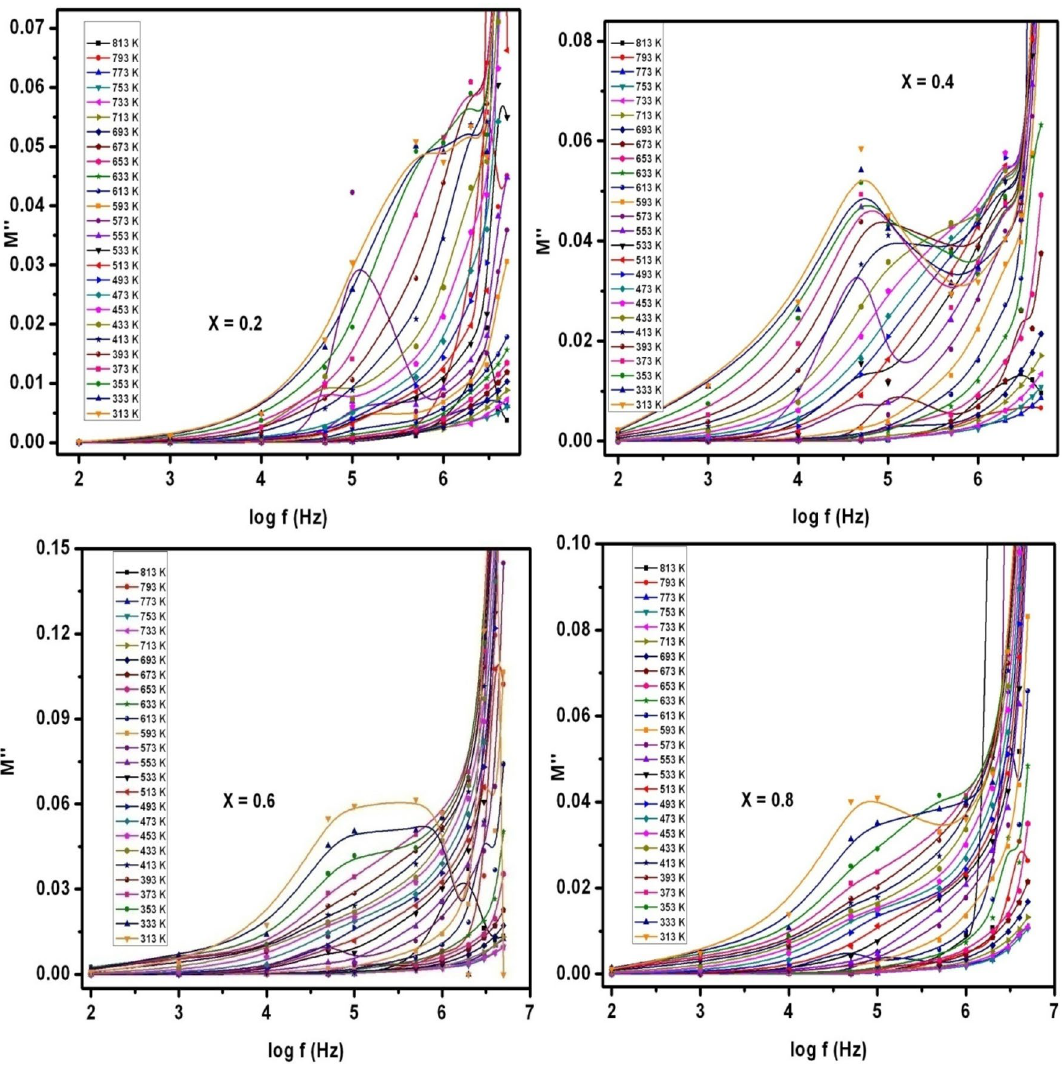
Figure 17. M ″ versus log f plots of SLFO